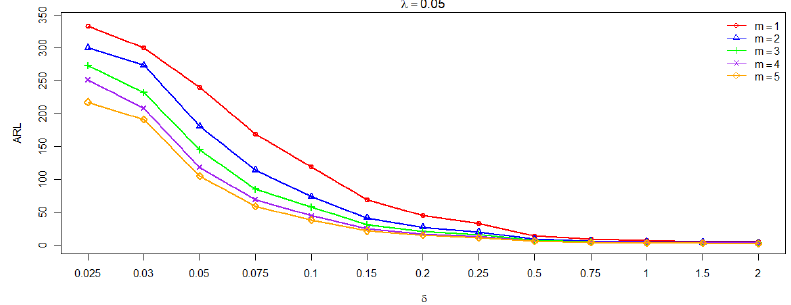
Figure 4. Effect of 𝑚 on ARL 1 performance of the proposed chart under 𝜔 = 0.05 .